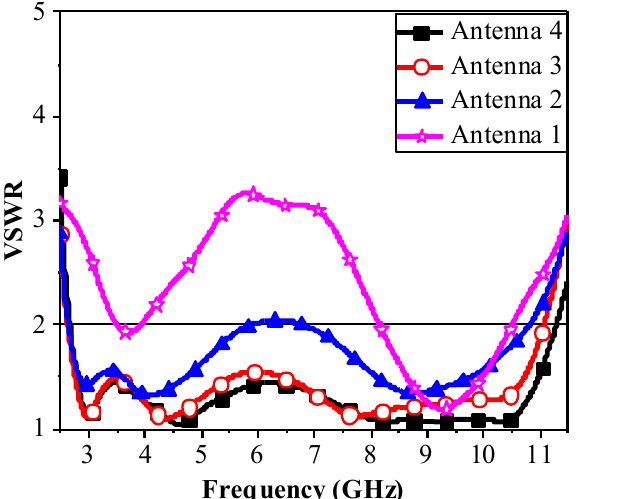
FIGURE 3. VSWR comparison of the designed antenna with those of the initial designs.